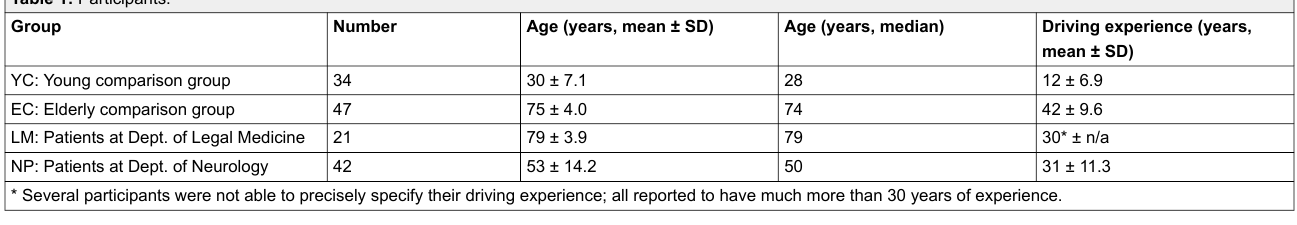
Table 2: Results of the examination and driving test of Group LM (patients at the Department of Legal Medicine).. Participant